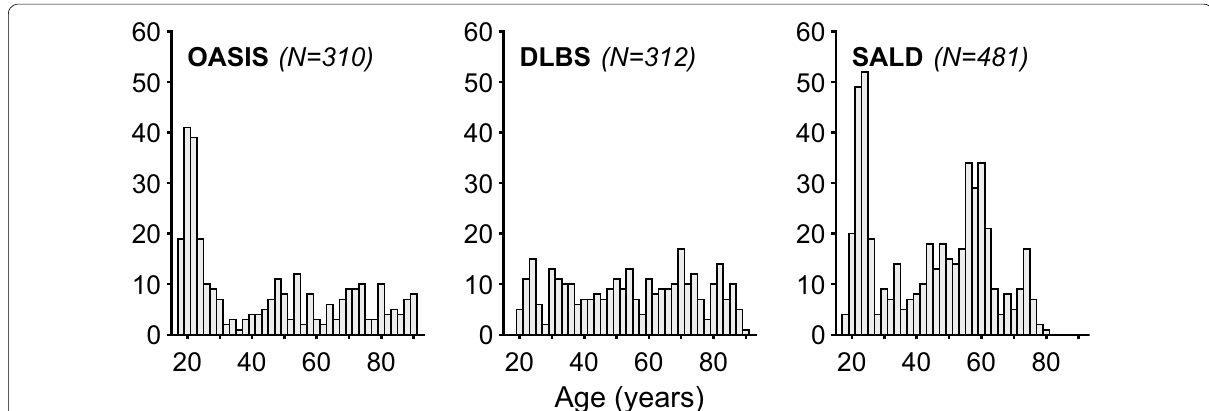
Fig. 2 Histogram of age distribution for the three aging datasets: OASIS, DLBS, and SALD, only for participants included in the sulcal morphology analyses. Each bar corresponds to a 2-year age-range